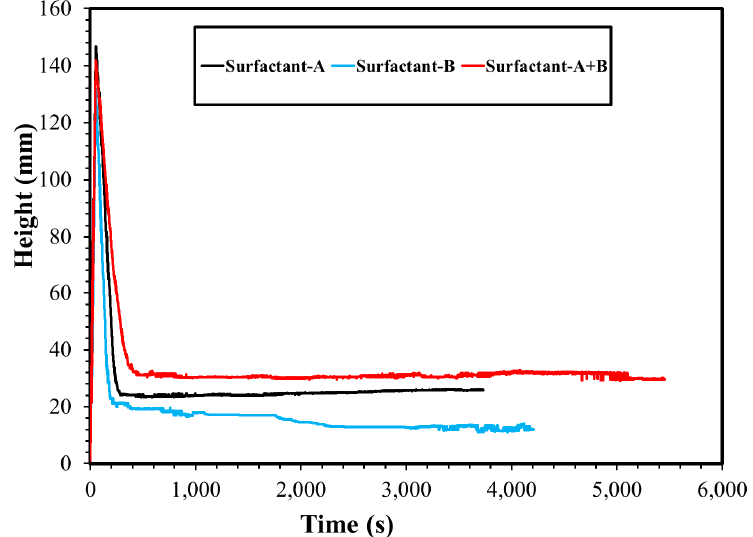
Figure 7. Foamability of different surfactant systems in seawater using CO 2 injection at high temperature (80 °C).